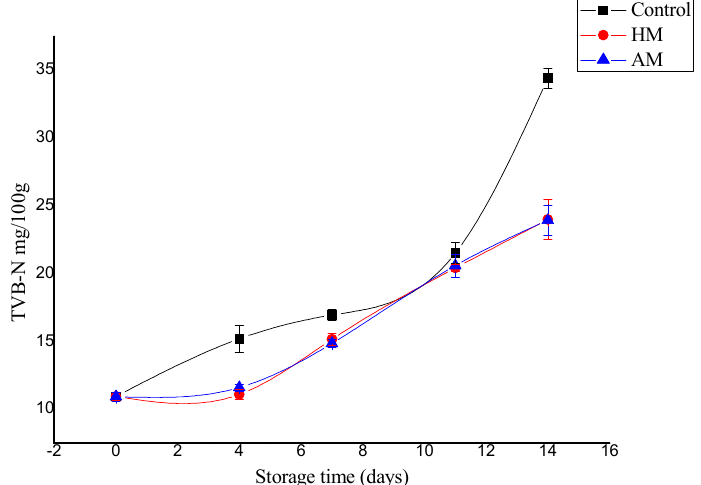
Figure 1. Changes in total volatile base nitrogen (TVB-N) values of control, Hypnea musciformis (HM), and Acanthophora muscoides (AM)treated shrimp muscle relative to days of storage at 0 °C (average ± standard deviation) .